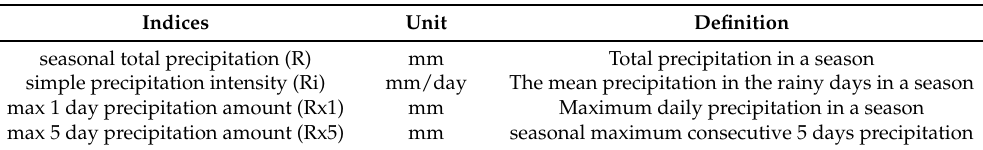
Table 1. Precipitation indices and their definitions in this study.